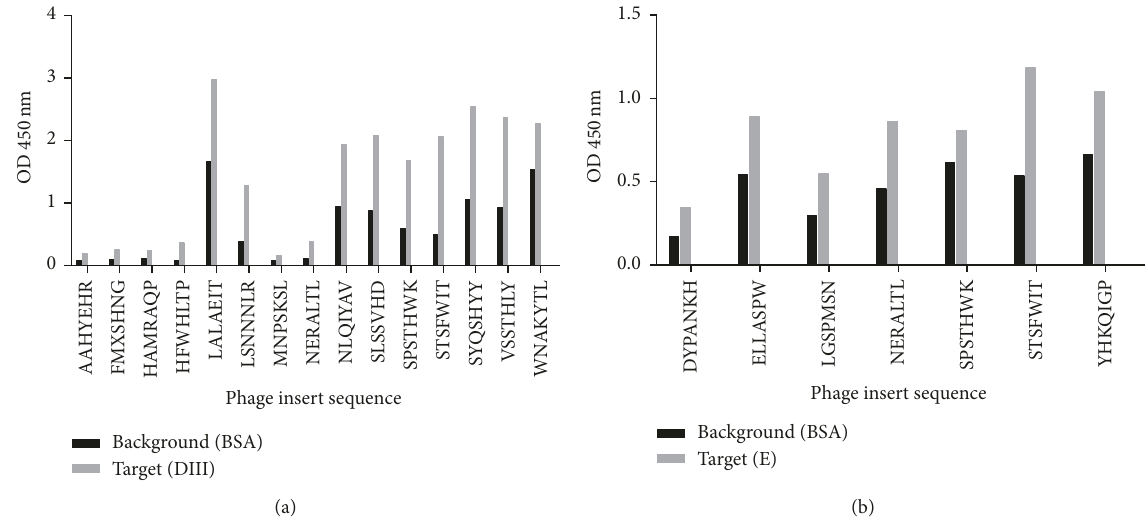
Figure 3: In vitro binding of selected clones as shown by phage-ELISA. Absorbance values by ELISA when phages are incubated in the presence of solid phase-bound specific ligand (target) or unspecific ligand (bovine serum albumin, as background). The binding of phages wasrevealedbyanti-M13antibody.(a)Resultsofphage-ELISAusingEdomainIIIastarget.(b)ResultsobtainedwhenusingfullEglycoprotein as